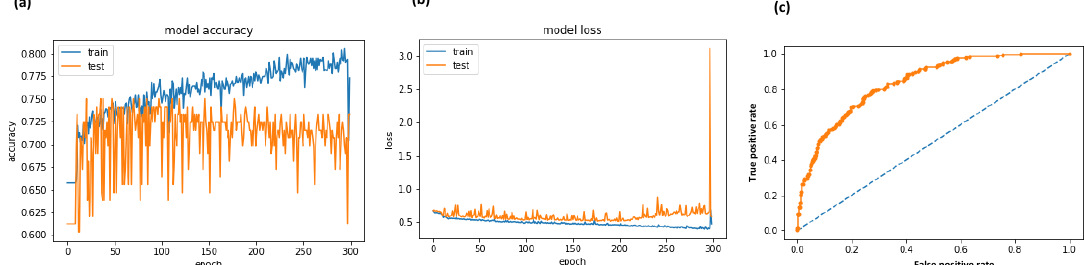
Figure 9. LSTM results (training dataset = 85%, testing dataset = 15%): ( a ) Model accuracy versus epochs; ( b ) model loss versus epochs; ( c ) ROC curve.